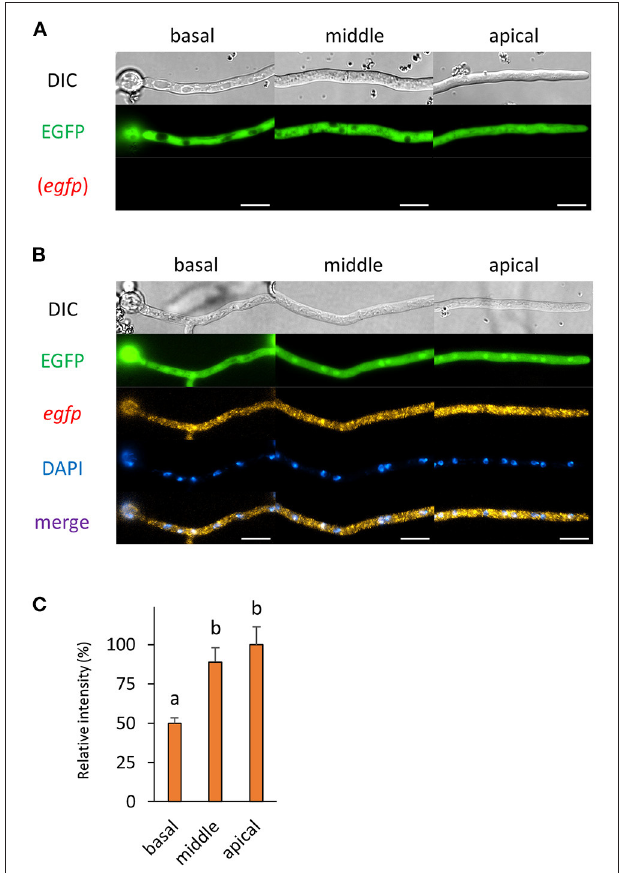
FIGURE 3 | The fluorescence derived from EGFP protein and egfp mRNA was observed in hyphal cells of the cytoplasmic EGFP-expressing strain. (A) Cytoplasmic EGFP was observed in live cells. (B) smFISH with egfp probe resulted in the observation of the fluorescence of cytoplasmic EGFP and egfp mRNAs. Nuclei were stained with DAPI. Bars, 10 µ m. (C) Relative fluorescence intensity of egfp mRNA was determined at apical, middle, and basal cells. Bars show mean with standard error. Significant difference at P < 0.05 between a and b (Tukey–Kramer test, n = 10 cells).